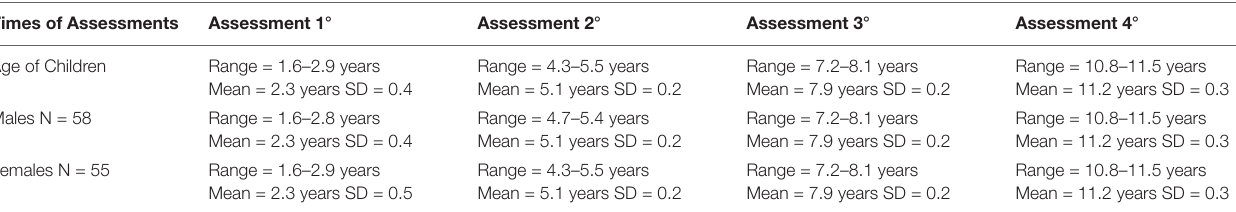
FIGURE 1 | Patterns of drop-out. The denominator for each percentage is the number of children in the level immediately above. In total, 128 children (53%) dropped out from the Assessment 1 ◦ (Time of Diagnosis: at age 2) to Assessment 2 ◦ (at age 5), Assessment 3 ◦ (at age 7), and Assessment 4 ◦ (at age 11). TABLE 1 | Means of age (SDs) and gender of children who were assessed at all four